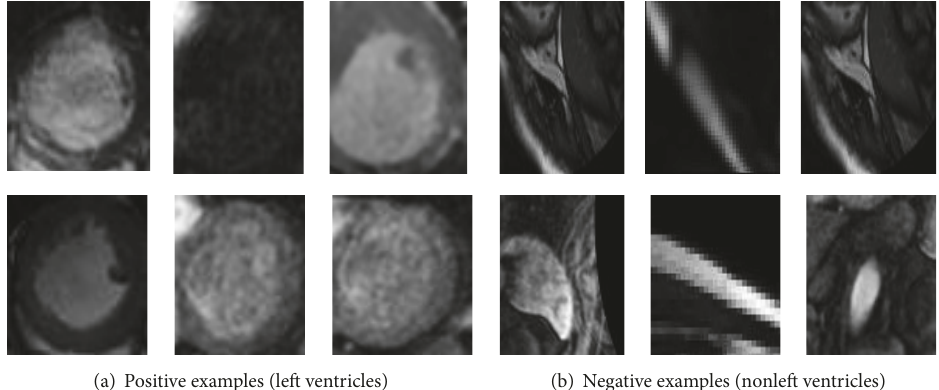
Figure 3: Samples for (a) left ventricles (positive examples) and (b) nonleft ventricles (negative examples).